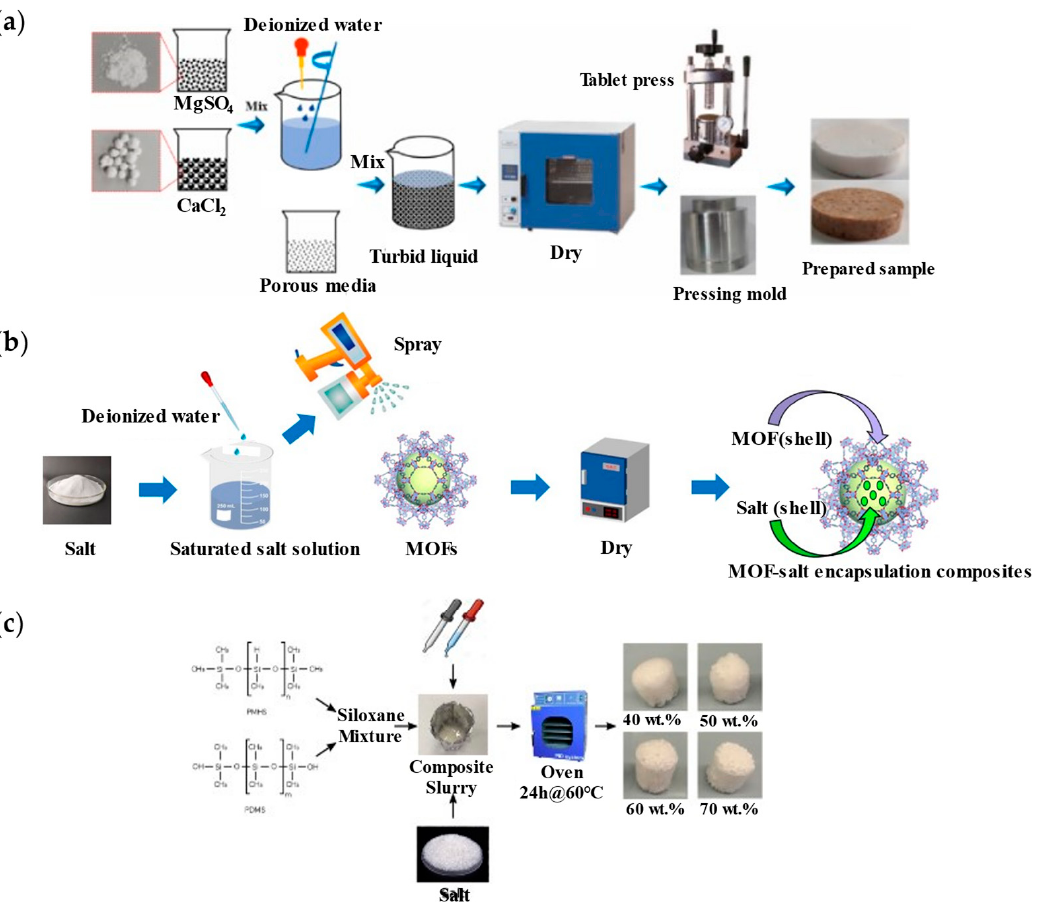
Figure 18. Preparation process for the TCES composite materials: ( a ) wet impregnation [110]; ( b ) encapsulation (spray-drying); and ( c ) foam synthesis [184]: Reprinted with permission from Ref. [110] Copyright © 2021 Elsevier B.V. All rights reserved; with permission from Ref. [184] Copyright © 2018 Elsevier B.V. All rights reserved.